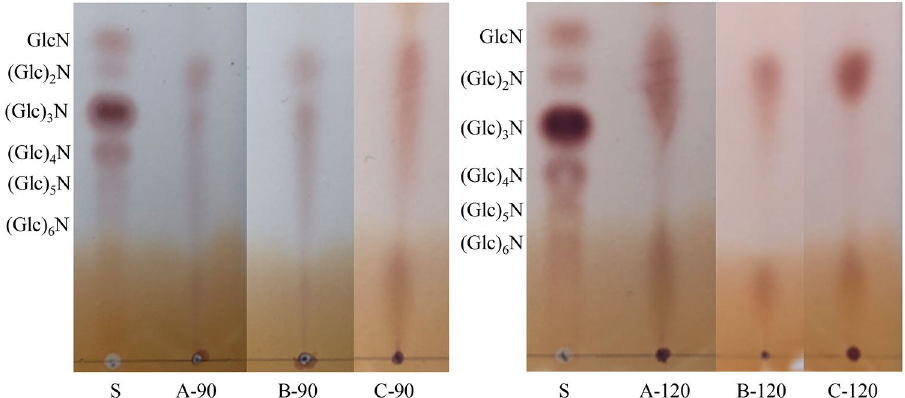
Figure 6. TLC of chitooligosaccharides from crab shell chitosan by deacetylation at 90 °C and 120 °C. S: a standard mixture of